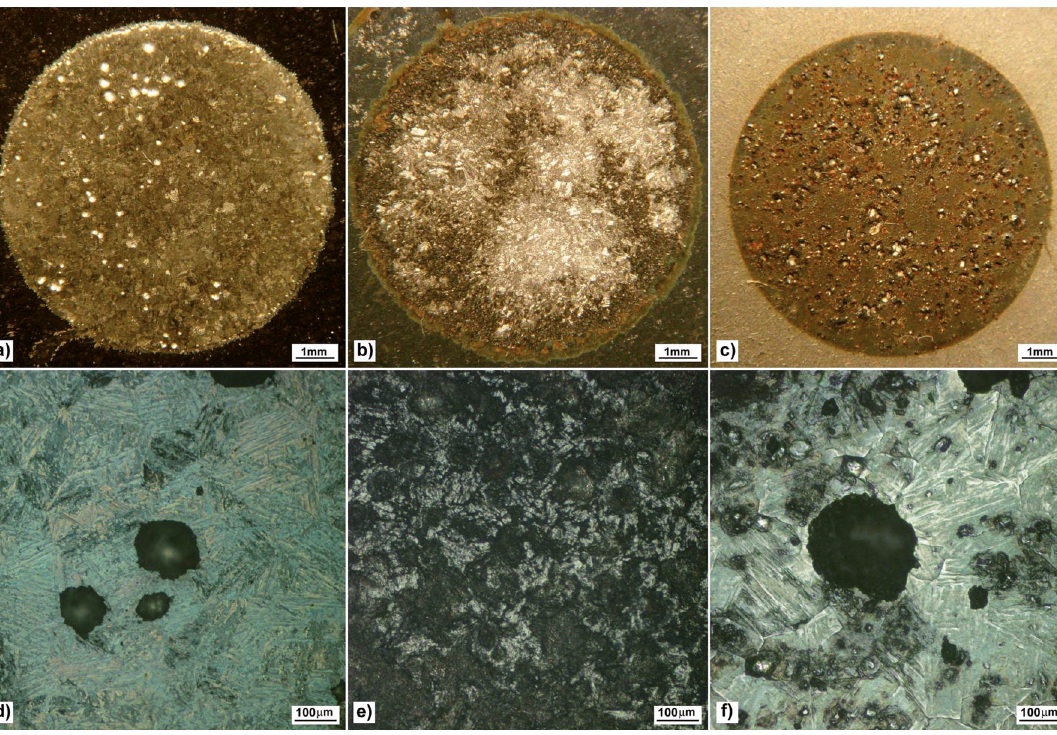
Figure 6. Light optical micrographs from the corroded region of plasma nitrocarburised SMSS at (a, d) 400°C, (b, e) 450°C and (c, f) 500°C after potentiodynamic polarization in 3.5% NaCl